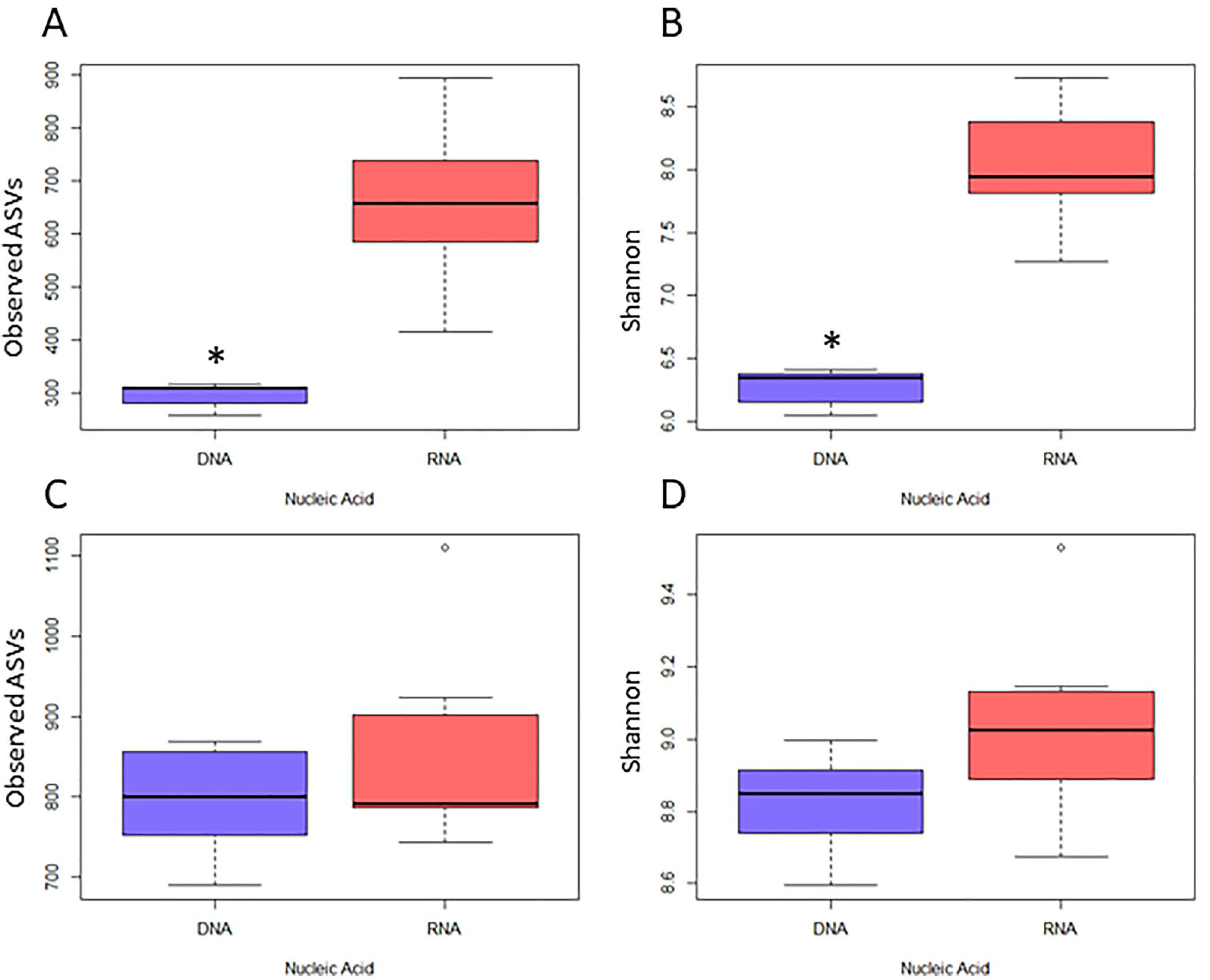
Figure 4. Alpha diversity metrics for DNA (blue) vs. RNA (red) metabarcoding templates for the 18S gene ( A and B ) and for the COI gene ( C and D ). Bold middle line represents the median ASVs, and upper and lower box limits represent the upper and lower quartiles, respectively. Observed ASVs are reported in A and C, and Shannon Diversity Index scores are reported in B and D. Significant differences ( p < 0.01) in diversity between DNA and RNA are denoted by an asterisk and were detected using a Kruskal-Wallis test (n =